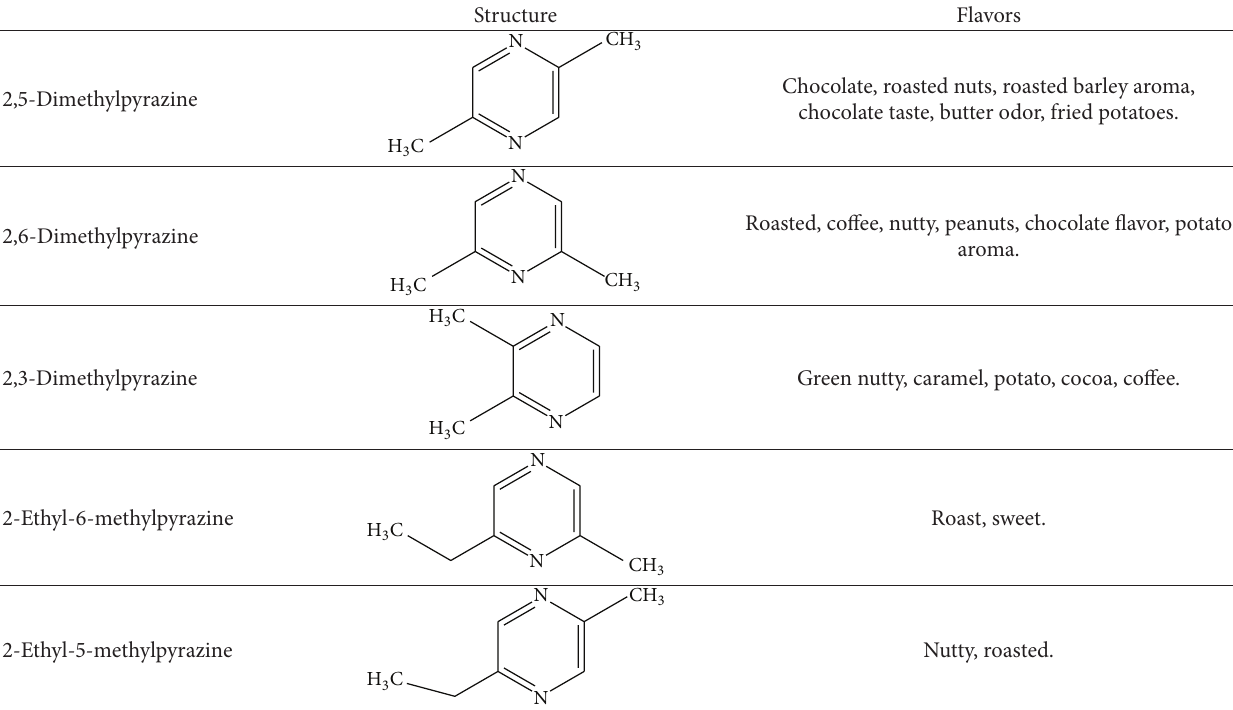
Table 1: Pyrazines commonly found in meat products and their published a flavor